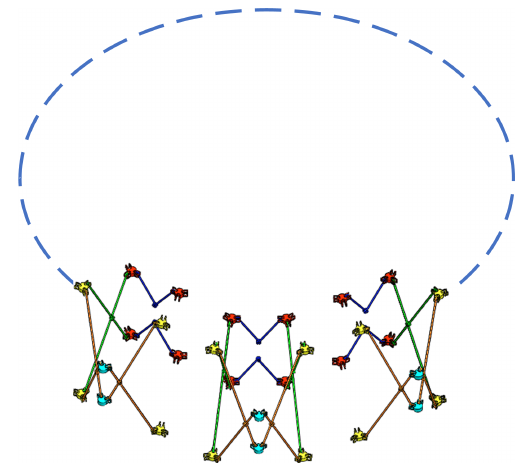
Figure 12. Topology diagram of the screw constraint of the non- closed-ring deployable mechanism